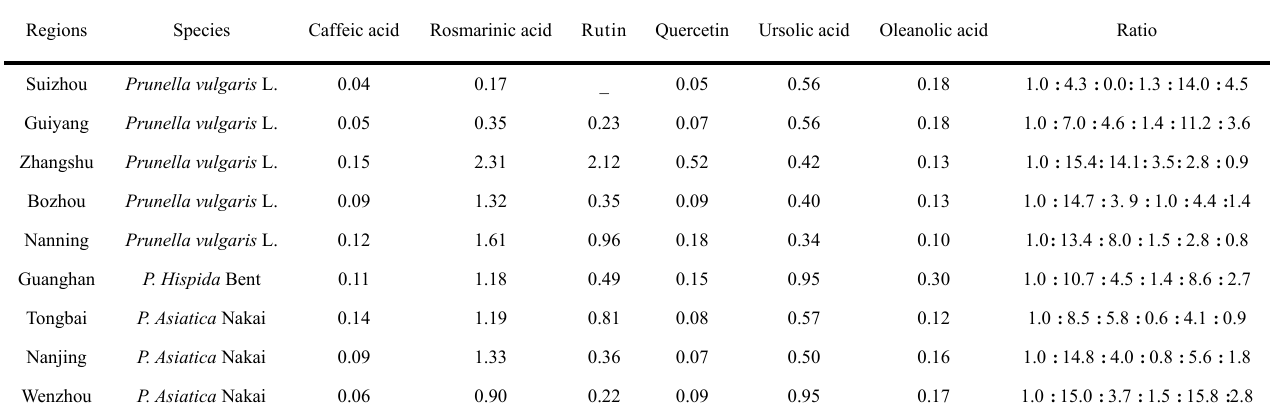
Table 2. Contents of six compounds in Prunella spp. and their ratios (mg/g).